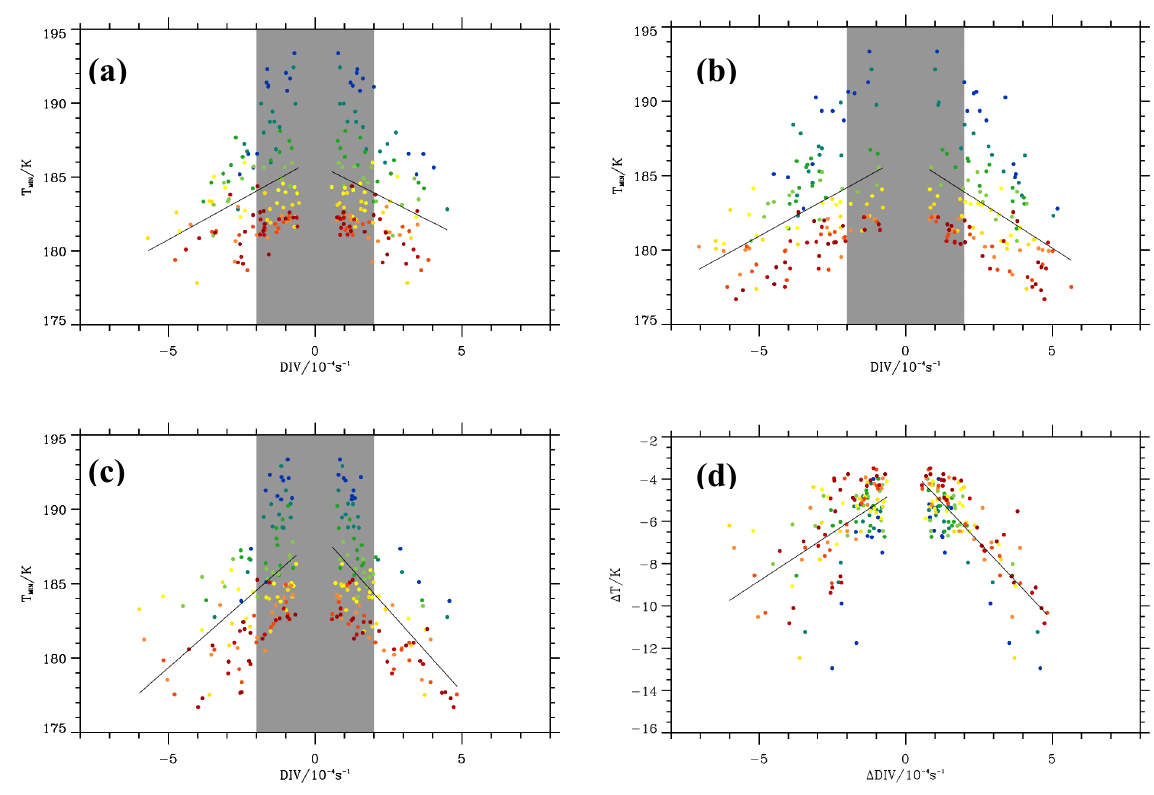
Fig. 18. Stratospheric gravity waves: correlation between the minimum temperature T MIN and DIV MIN and DIV MAX over Greenland (60 Figure 18: Stratospheric gravity waves: Correlation between the minimum temperature T 4 to 85 ◦ N, 60 to 20 ◦ W) for isentropic levels from 430K, 450K, ..., 610K (from blue to red) in the period 2 to 4 January 2010. ECMWF operational analyses interpolated at a regular 2 . 50 × 2 . 50 ◦ (a) and 0 . 25 × 0 . 25 ◦ (b) latitude/longitude grid, respectively. The correlation and DIV and DIV over Greenland (60°N ... 85°N, 60°W ... 20°W) for isentropic levels 5 coefficients T MIN = f (DIV MIN ) and T MIN = f (DIV MAX ) amount to 0.34 and − 0.27 for (a) and 0.46 and − 0.42 for (b) . Panel (c) : same MIN MAX data as for (b) taken from a limited domain at the east coast of Greenland (60 to 70 ◦ N, 40 to 20 ◦ W); here, the correlation coefficients amount to 0.53 and − 0.62. Panel (d) : same data as in panel (c) but for 1T = T MIN − T AVE = f (1 DIV − ) and 1T = f (1 DIV + ) with from 430 K, 450 K, … , 610 K (from blue to red) in the period 2 to 4 January 2010. ECMWF 6 1 DIV − = DIV MIN − DIV AVE and 1 DIV + = DIV MAX − DIV AVE . Here, the correlation coefficients amount to 0.54 and − operational analyses interpolated at a regular 2.50° × 2.50° (a) and 0.25° × 0.25° (b) 7 latitude/longitude grid, respectively. The correlation coefficients T ) amount to 0.34 and -0.27 for (a) and 0.46 and -0.42 for (b). Panel (c): Same data 9 f(DIV MAX as for (b) taken from a limited domain at the east coast of Greenland (60°N … 70°N, 40°W … 10 20°W); here, the correlation coefficients amount to 0.53 and -0.62. Panel (d): Same data as in 11 panel (c) but for Δ T = T – T = f( Δ DIV – ) and Δ T = f( Δ DIV MIN AVE + DIV and Δ DIV = DIV – DIV . Here, the correlation coefficients amount to 0.54 13 AVE MAX AVE and -0.82 14